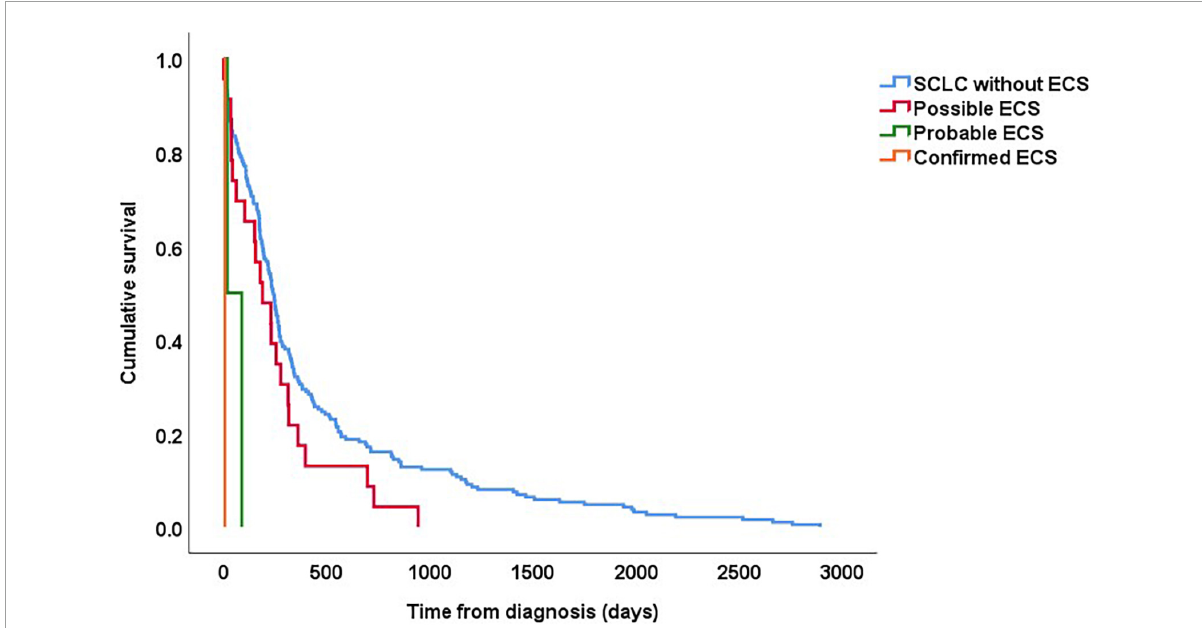
FIGURE2 Kaplan–Meier curves showing survival in patients with SCLC based on whether they had “confirmed,” “probable,” and “possible” ECS. For all patients, follow-up started on the date of histological